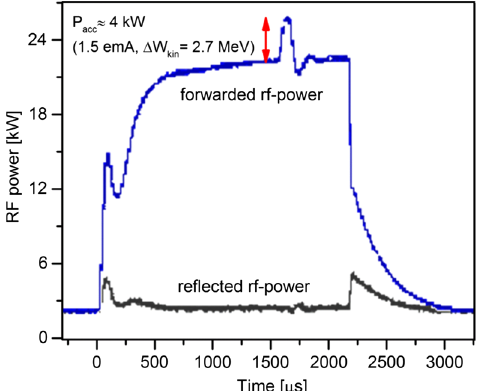
FIG. 9. Forward and reflected rf power; the impedance is decreased while the beam is entering the cavity. The low level control system regulates the rf amplifier to a higher forwarded rf power and compensates the beam dependent impedance drop (peak at 270